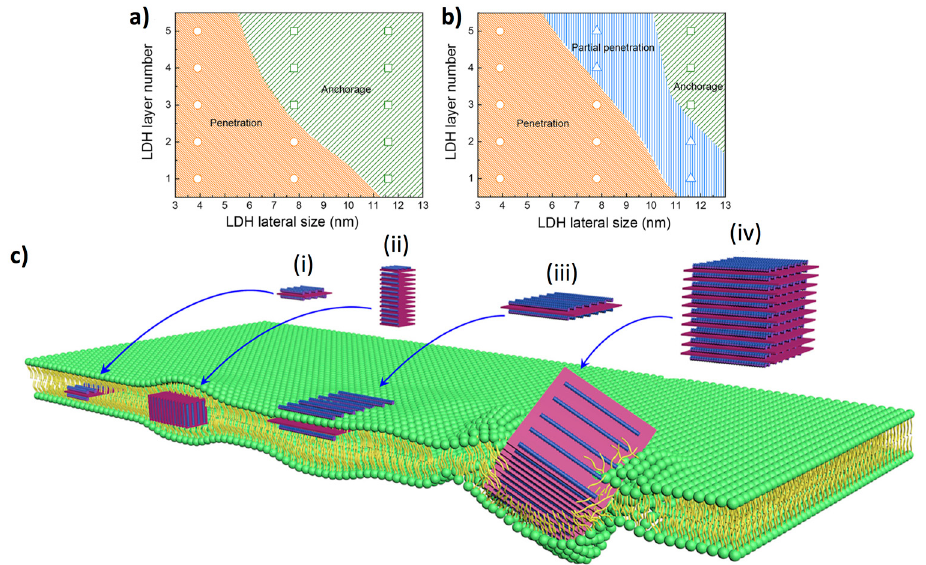
Figure 3. Interaction of DNA-LDH hybrids of di ff erent lateral layer sizes and thicknesses with